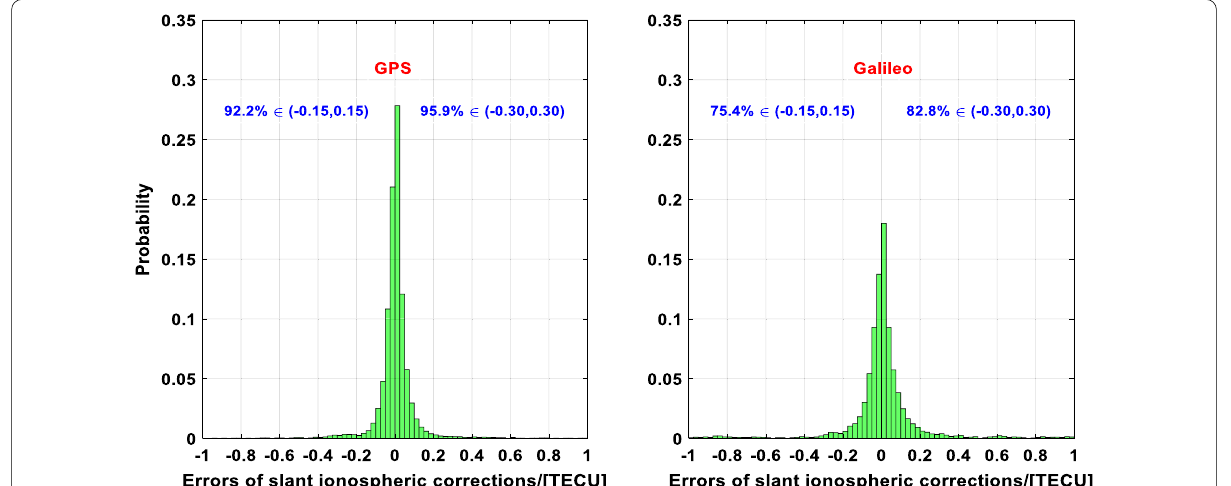
Fig. 10 Error distribution of the SD slant ionospheric delays in different satellite systems (left panel: GPS; right panel: